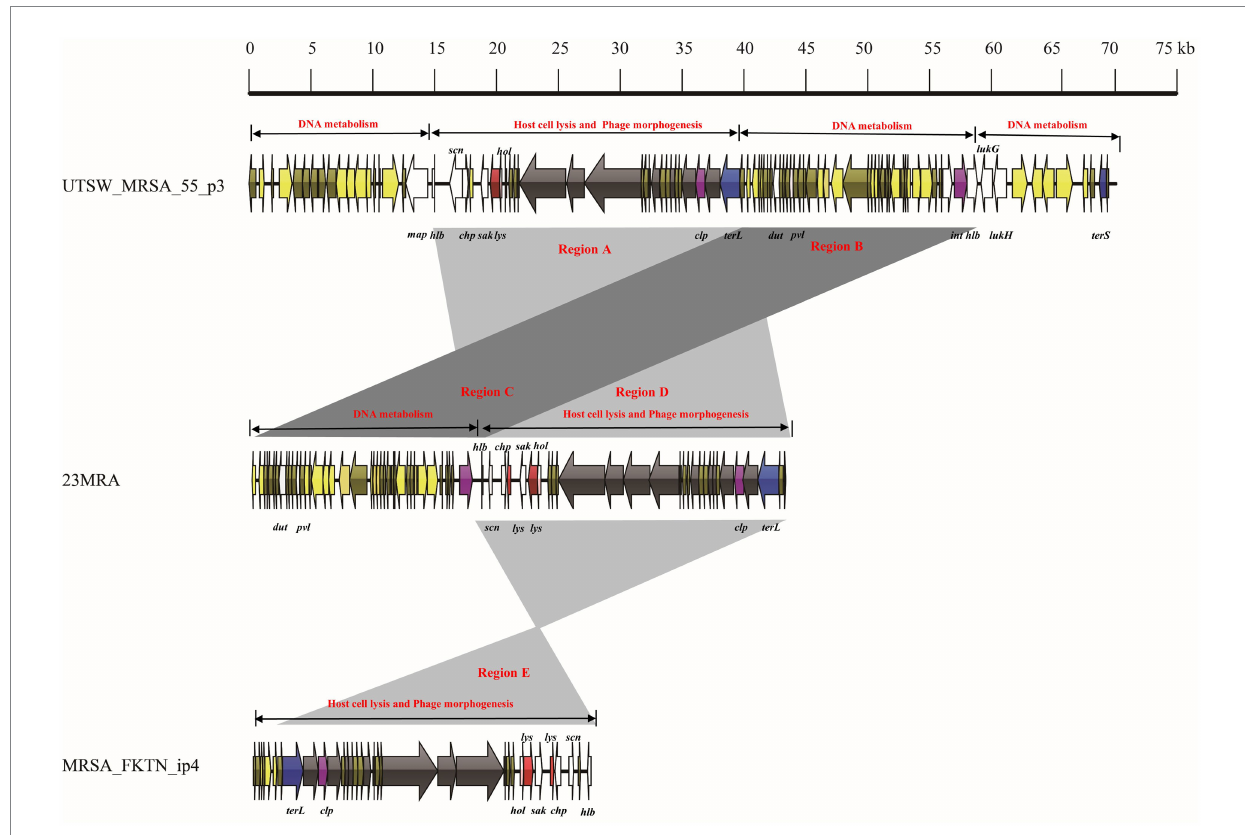
FIGURE 5 Comparative structural analyses of lytic phage-3_AJ_2017 with intact prophage ST20130943_p1 and incomplete prophage SA3_LAU_ip3.